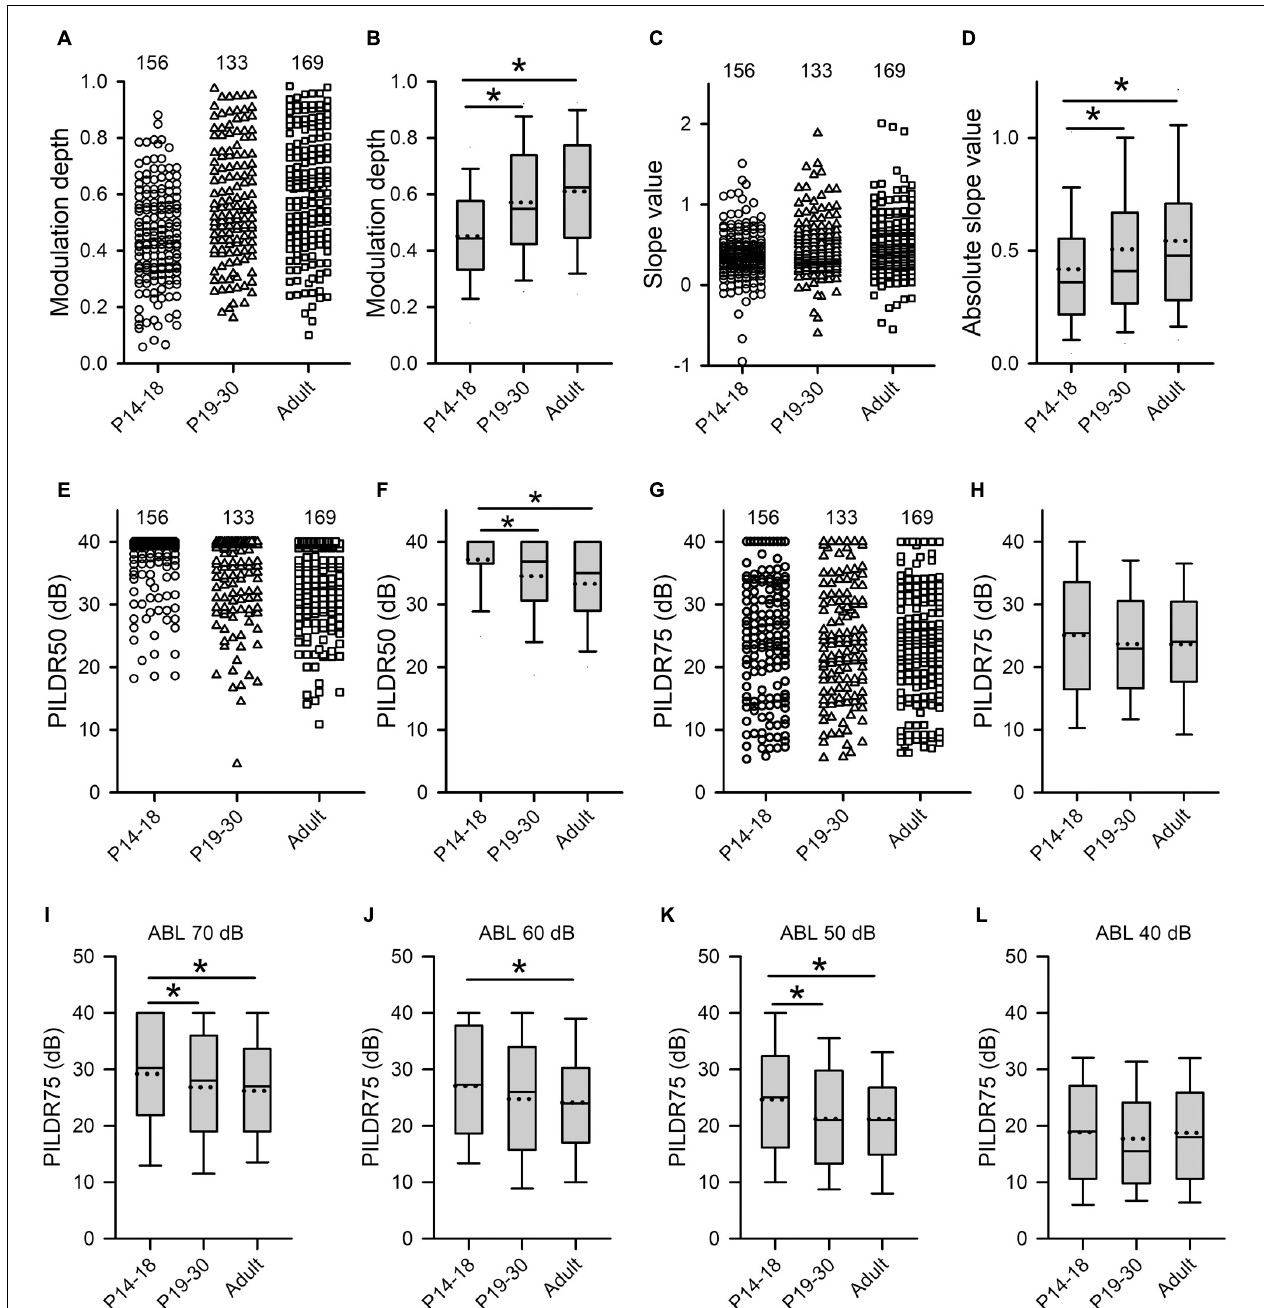
FIGURE 7 | Age-related changes in both the sensitivity and the selectivity of AI neurons to ILDs determined from the ILD response functions in the three age groups. (A–H) Population data showing the distributions of modulation depth (A,B) , slope value (C,D) , PILDR50 (E,F) , and PILDR75 (G,H) in both scatter plots and box plots, respectively. In the scatter plots, each symbol represents the data from one neuron. The PILDR50 and the PILDR75 data shown in the second row are determined from the averaged ILD response functions across ABL. (I–L) Box plots showing the distributions of PILDR75 determined from the ILD response functions at ABL 40–70 dB. * indicates significant difference between two groups (Mann–Whitney U -test, p < 0.05). The greater values in the modulation depth and the absolute slope value indicate greater sensitivity to ILDs. Moreover, the smaller values in the PILDR50 and the PILDR75 indicate greater selectivity to